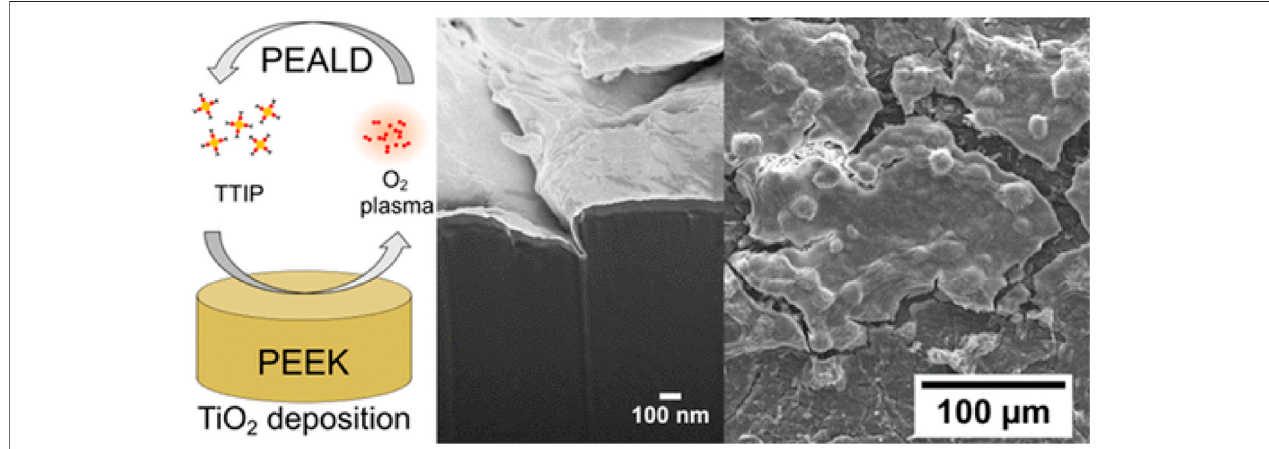
FIGURE 10 | Deposition mechanism and SEM images of TiO American Chemical Society.